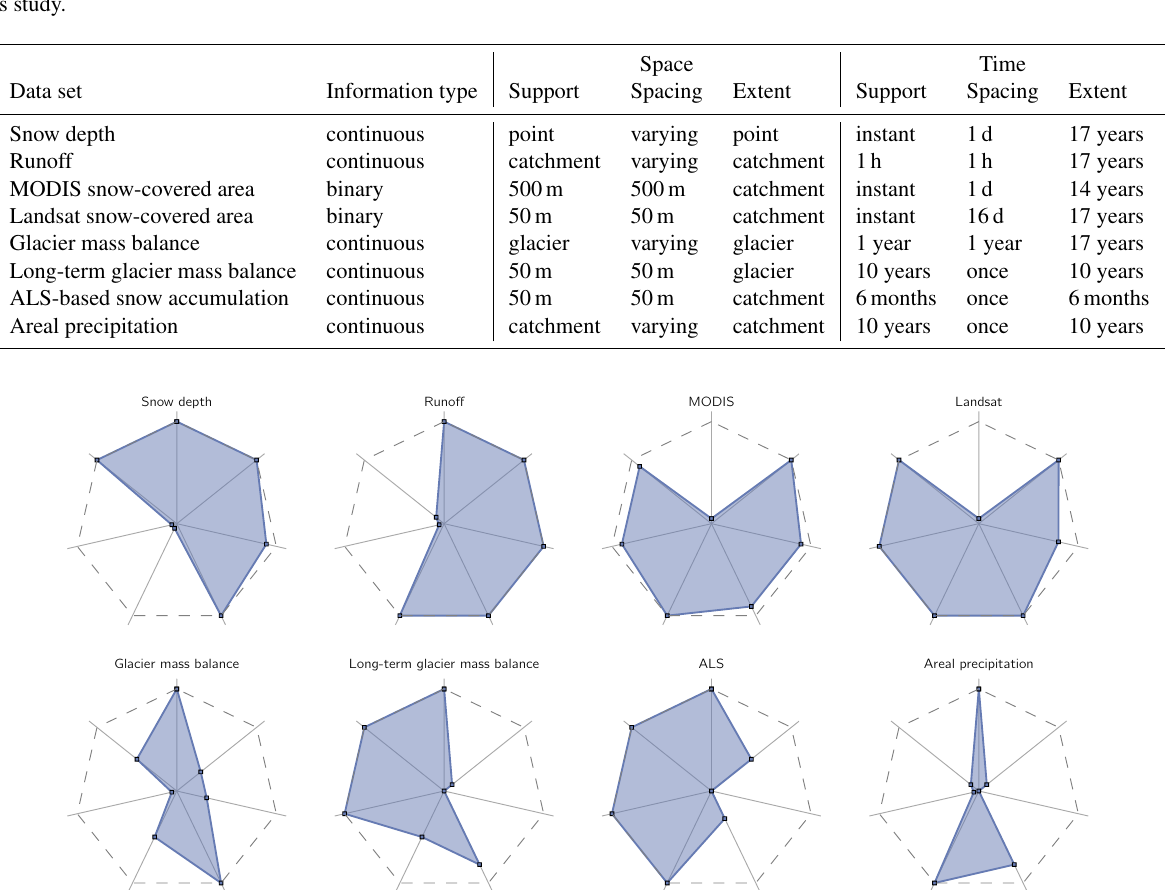
Table 3. Information type (binary or continuous) as well as spatial and temporal support, spacing, and extent of the validation data sets used in this study.